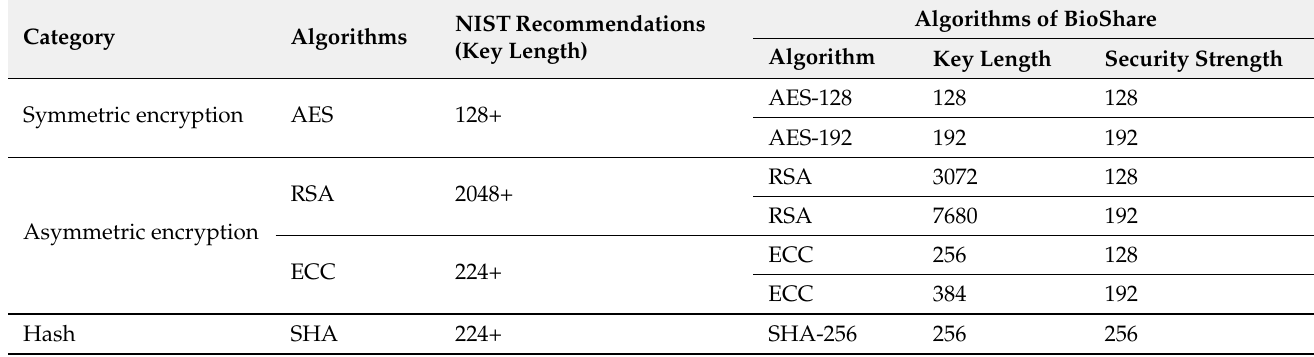
Table 10. Security Strength of Cryptographic Algorithms of BioShare.